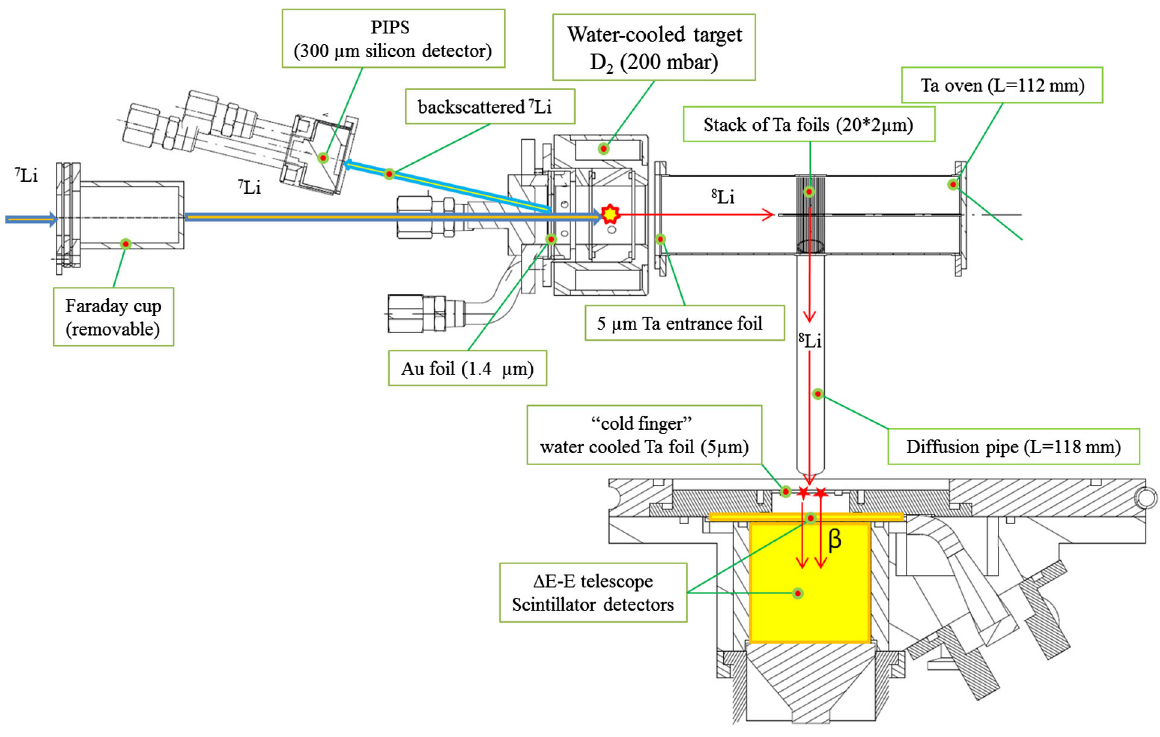
FIG. 9. Experimental setup for the 8 Li runs.